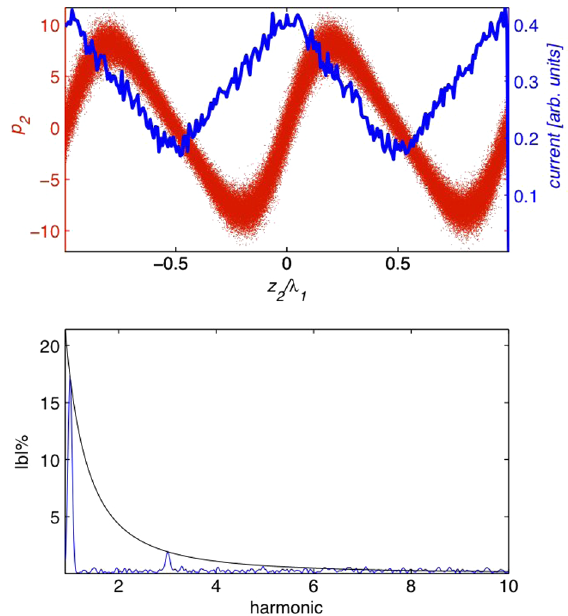
FIG. 7. Three modulator generation of odd-harmonic bunching that goes like b ½ð 2 h (cid:1) 1 Þ k 1 (cid:5) ¼ b ð k 1 Þ = ð 2 h (cid:1) 1 Þ 2 for the emission of triangular radiation fields. Top: Modified phase space and current distribution with A 1 ¼ 10 , A 2 ¼ 1 : 934 , A 3 ¼ 0 : 287 , Bottom: Bunching factors compared with 1 = ð 2 h (cid:1) 1 Þ 2 depen- dence of sawtooth